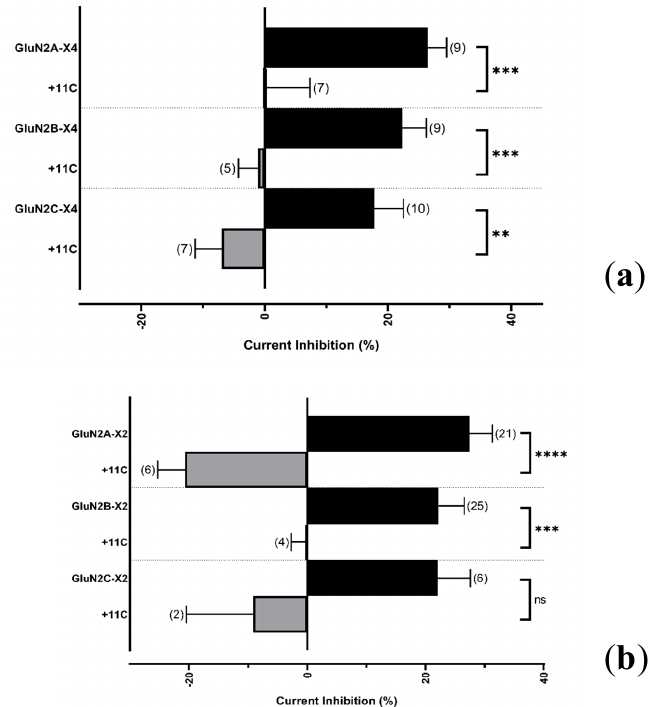
Figure 7. 11C peptide disrupts P2X–NMDAR cross-talk. Bar graphs representing the current inhibition obtainedfromcoapplicationofGluandATPforoocytesexpressingeitherP2X4( a )orP2X2( b )andNMDARs containing GluN2A-C, 30 min after injection with 11C (grey). The inhibited responses (black) are ablated by 11C. Agonist responses were normalized to the sum of the individual Glu and ATP responses for each oocyte and subtracted from 100%. The data are expressed as mean ± SEM and were analyzed using a Welch’s t -test. ns p > 0.05, ** p < 0.01, *** p < 0.001, **** p < 0.0001 Parentheses denote number of